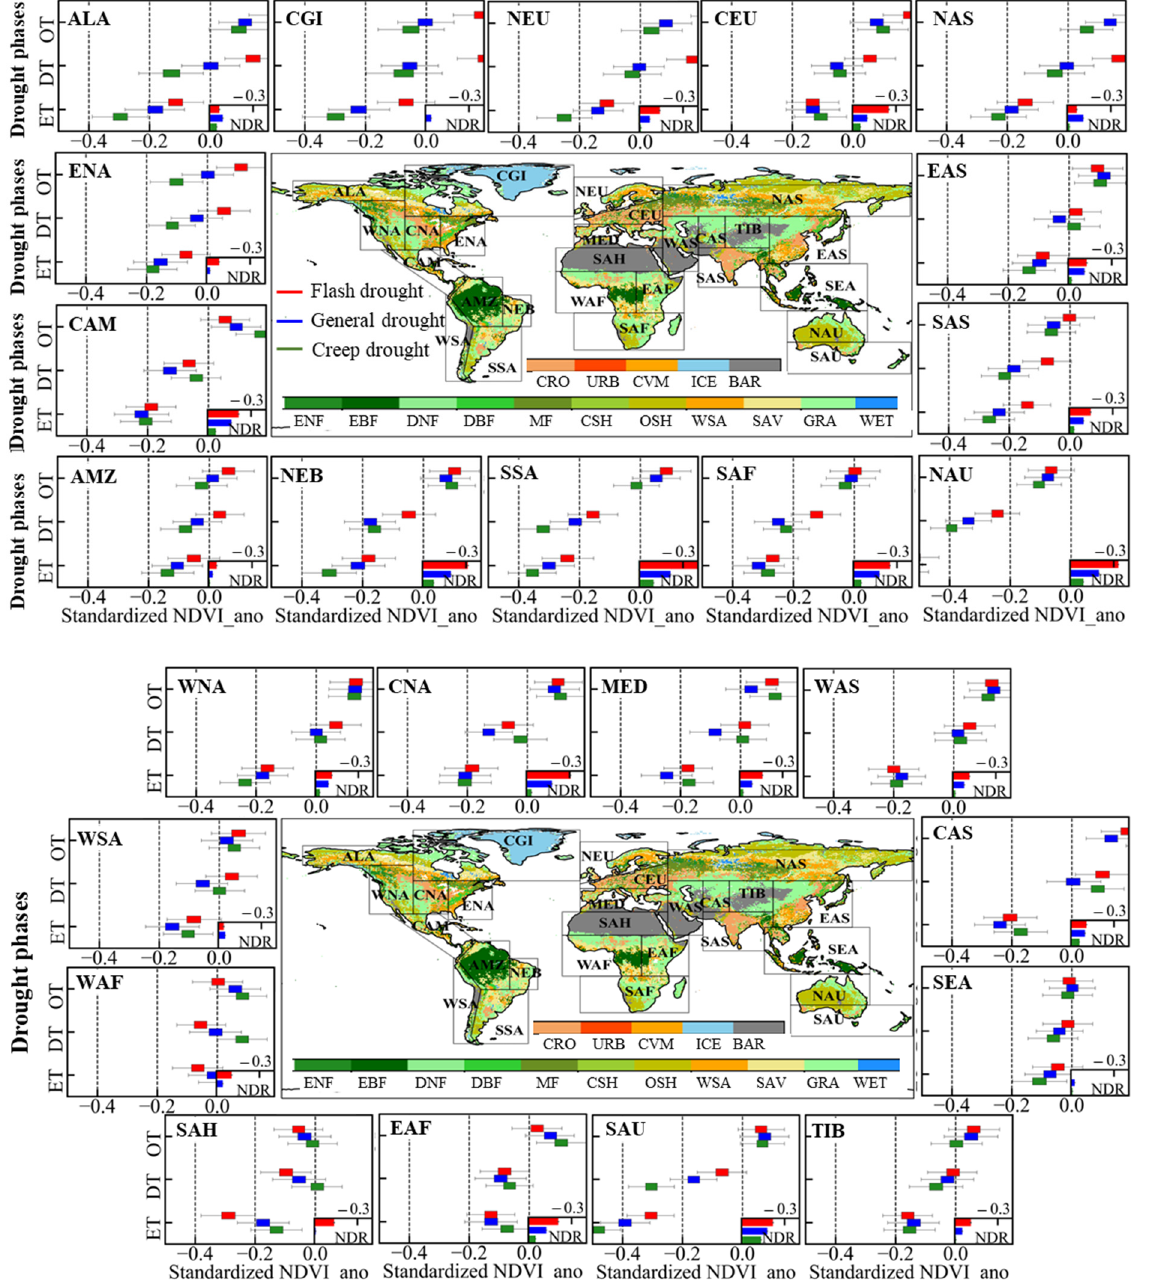
Figure 8. Ecological impacts of different drought types at onset timing (OT), development timing (DT), and drought end timing (ET) for parts of IPCC-SREX regions. For each boxplot, the inset at the upper left shows the probability of the month when droughts are most likely to happen, and the inset at the bottom right shows the mean decline rate of standardized NDVI anomaly (NDR, unit: % month − 1 ) during the drought onset